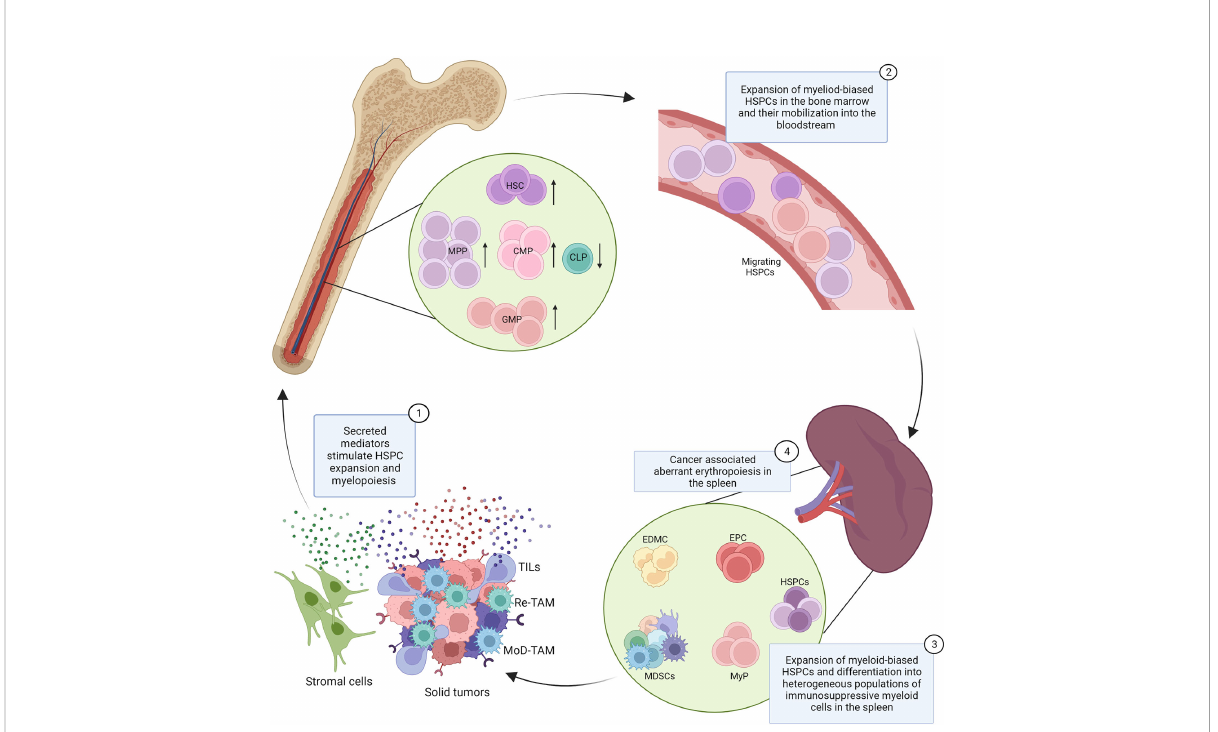
FIGURE 1 Dysfunction of hematopoiesis in cancer. Secreted mediators produced by cancer cells, tumor in fi ltrating leukocytes (TILs), and stromal cells (1) promote the expansion of hematopoietic stem cells (HSC), multipotent progenitors (MPPs), common myeloid progenitors (CMPs), and granulocyte monocyte progenitors (GMPs) in the bone marrow and their mobilization into the bloodstream (2). The cancer associated induction of extramedullary hematopoiesis is characterized by the expansion of hematopoietic stem and progenitor cells (HSPCs) and myeloid progenitor cells (MyPs) in the spleen and their local differentiation into heterogeneous populations of myeloid cells with immunosuppressive properties, known as tumor associated neutrophils/monocytes or myeloid-derived suppressor cells (MDSCs) (3). Cancer associated myelopoiesis also contributes to the production of monocyte-derived tumor associated macrophages (MoD-TAMs). Splenic extramedullary erythropoiesis is also reported in cancer, characterized by the expansion of erythroid progenitor cells (EPCs) in the spleen and the production of erythroid differentiated myeloid cells (EDMCs), with potent immunosuppressive properties (4). This model integrates fi ndings from multiple cancer types and experimental systems, and the indicated mechanisms may not be conserved across all